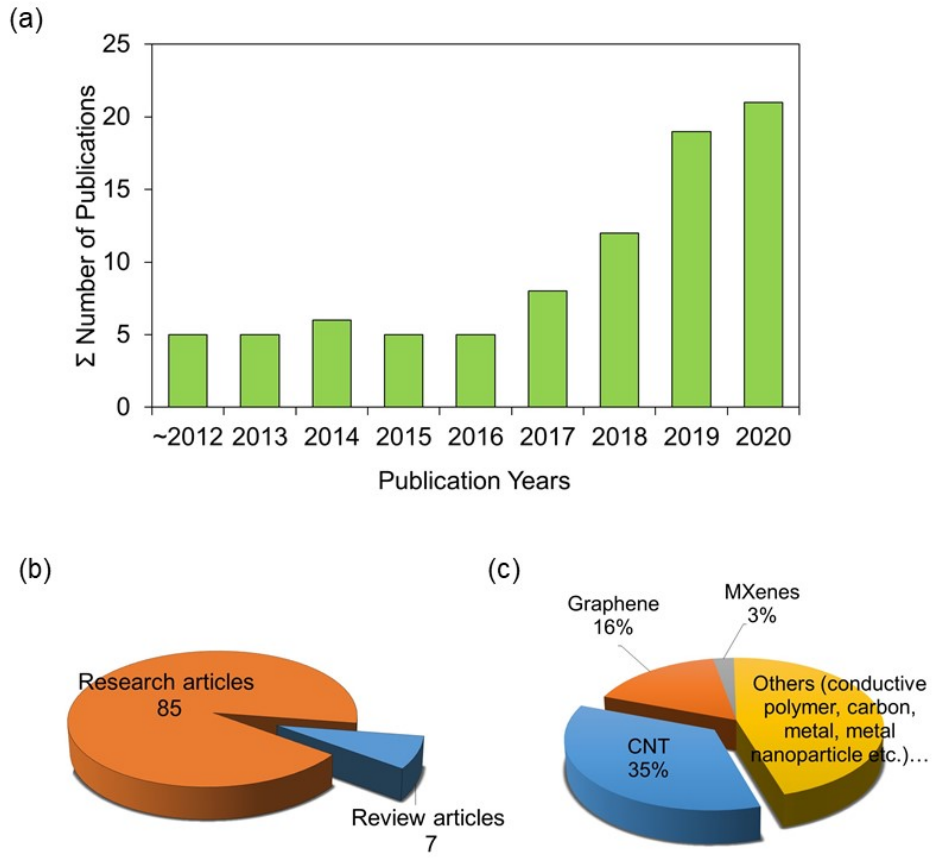
Figure 1. The research trend of the published papers related to electrically responsive membranes (ERMs) as of 15 October 2020: ( a ) annual publications of ERM papers based on Scopus database, and ( b ) article-type-based distribution (research vs. review). ( c ) Materials used for designing ERMs in previous studies. The list of the research articles was obtained by searching with keywords “(‘electrically conductive’ or ‘electrically responsive’ or ‘electro-conductive’ or ‘electro-active’ or ‘electro-responsive’) and ‘membrane’ and ‘water purification’” in Scopus, then manually removing unrelated articles.